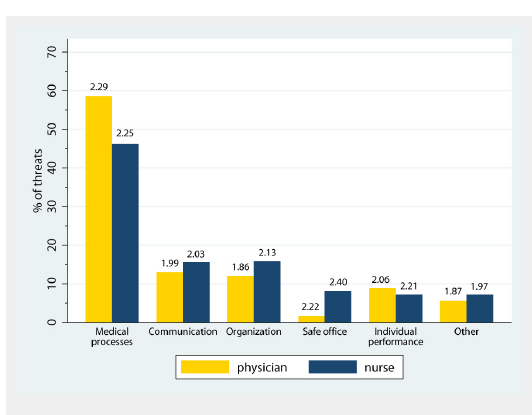
Figure 2 Frequency of cited threats by top-level category and occupational group (n = 936 threats). Numbers on top of bars indicate the mean priority assigned to that category (higher numbers indicate higher